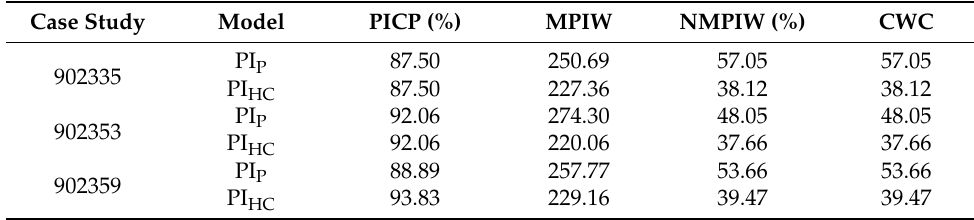
Table 3. PIs characteristics for test samples when the confidence level is